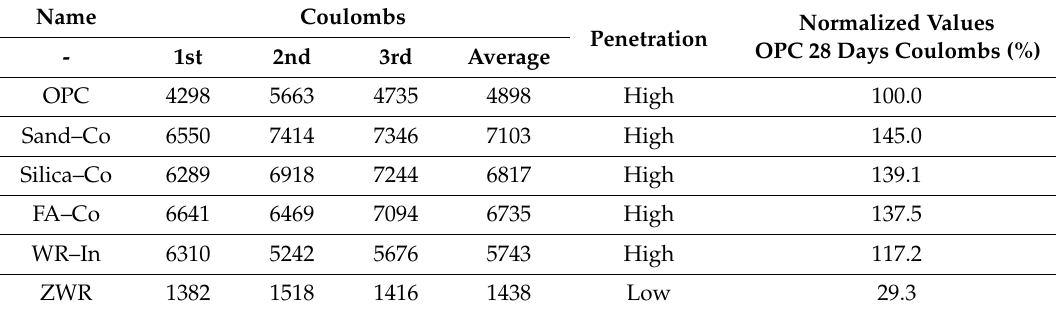
Table 13. Result of the resistance chloride ion penetration test.